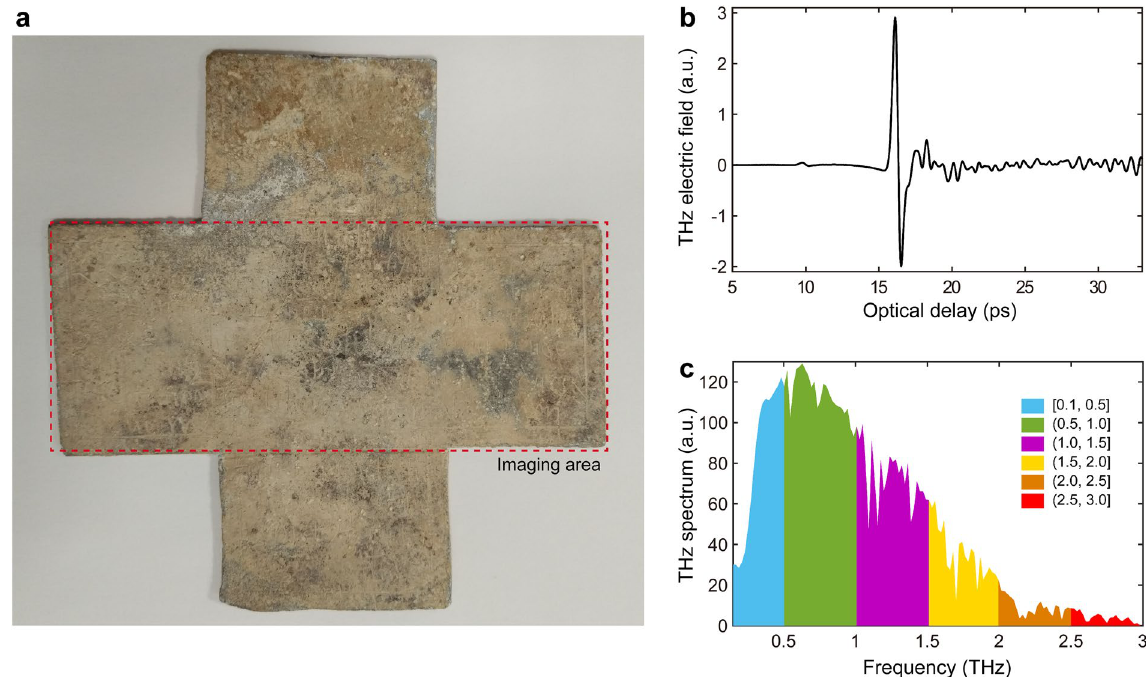
Figure 1. ( a ) Photograph of the Pb cross under investigation in this study. The dimensions of the cross are ∼ 11.5 cm by ∼ 11.5 cm with a thickness of ∼ 2 mm. The whitish appearance is due to corrosion. The presence of a text is suggested by incised features in the whitish areas with several characters readable where the corrosion is less well-formed. This is the condition in which the cross arrived in our laboratory. The horizontal arm of the cross is selected as the region of interest for THz imaging. ( b ) The THz reference signal in our system, which is recorded by setting a metal plate at the sample position. ( c ) The power spectrum of the reference THz pulse. The full spectrum of a broadband THz pulse is divided into six frequency bands with a bandwidth of ∼ 0.5 THz. THz multispectral images are obtained based on the frequency components in each frequency